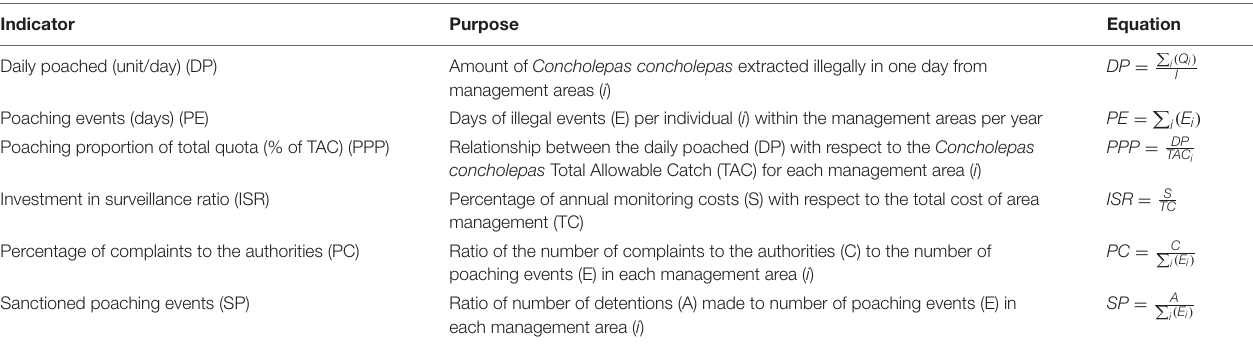
FIGURE 1 | Examples of landscapes in the northern and southern part of the study area. (A) Caleta Los Sauces in the northern study area. (B) Hualaihue Estero in the southern study area. TABLE 2 | Indicators for evaluation and comparison of illegal activity within management